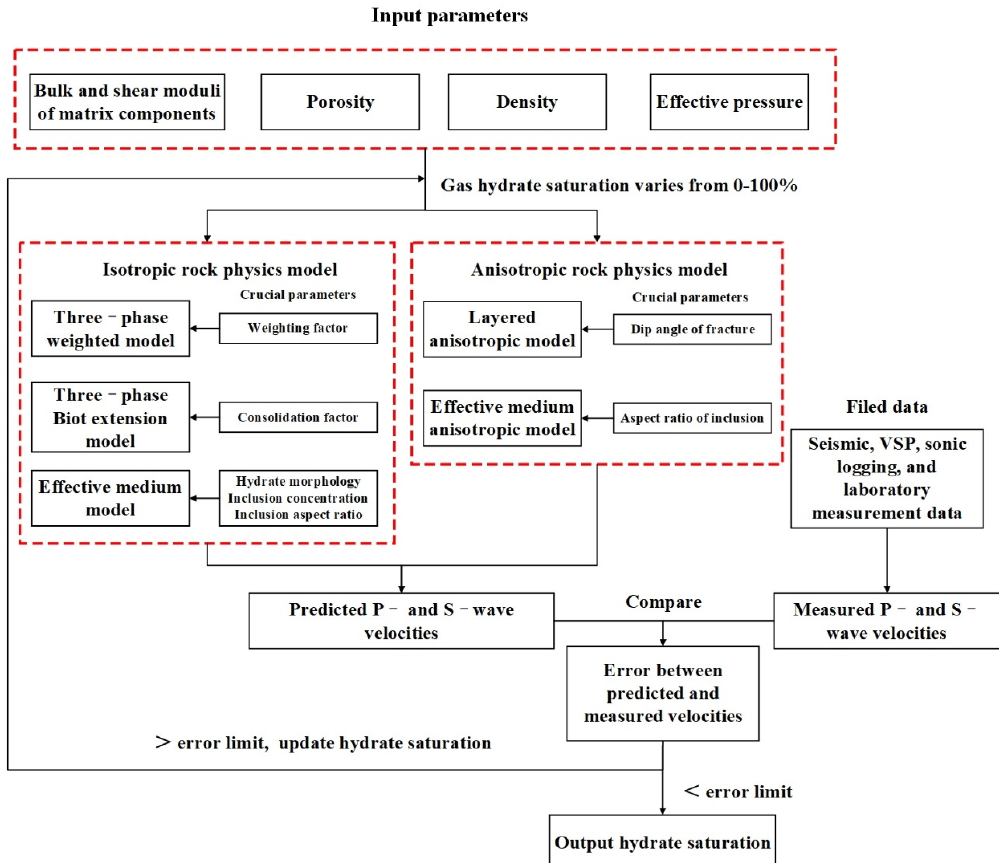
Figure 10. Workflow of hydrate saturation prediction from P- and S-wave velocities based on rock physics models.